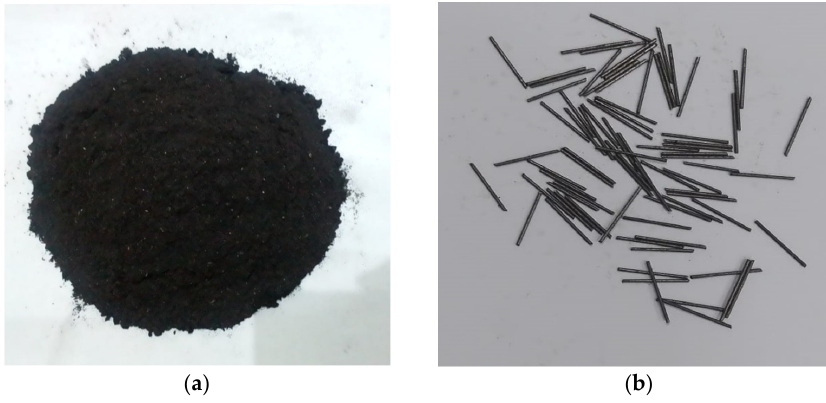
Figure 2. Materials used: ( a ) coal ash; ( b ) steel fibers.